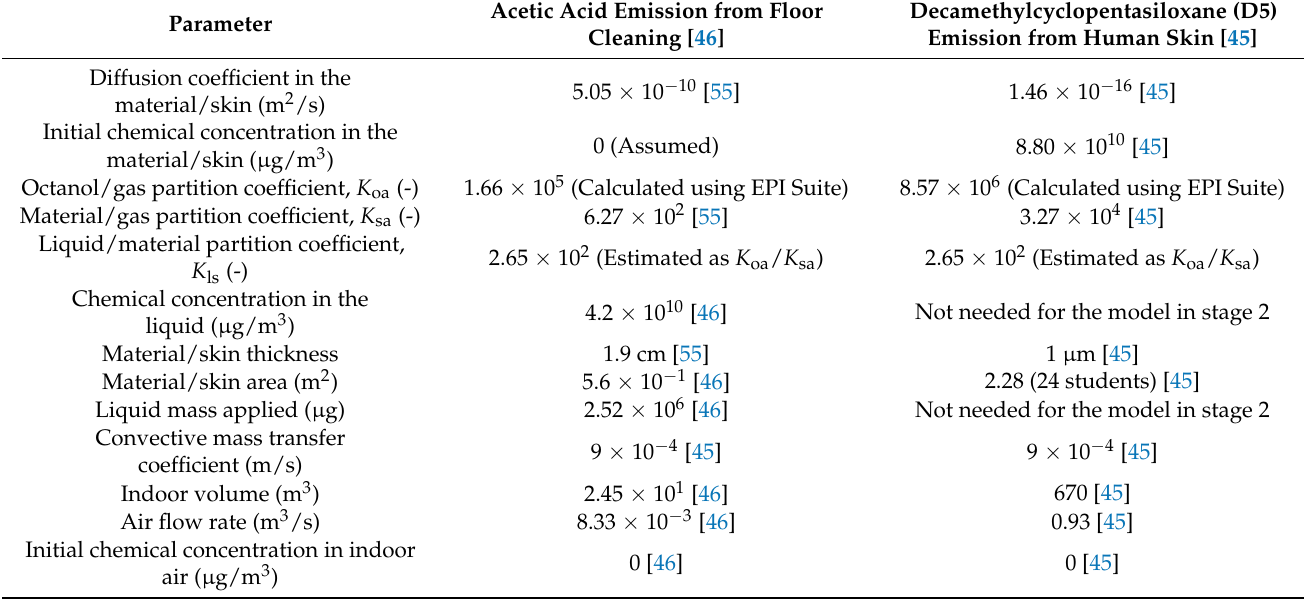
Table 1. Input data for modeling indoor concentrations associated with product